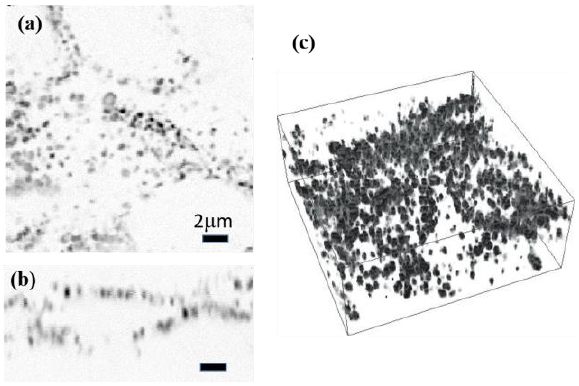
Figure 5. Photothermal images of a slice of mouse melanoma in the ( a ) lateral and ( b ) axial planes. ( c ) 3D rendering of a set of 30 image slices. Image size is 19.6 × 19.6 × 8.2 μm 3 .